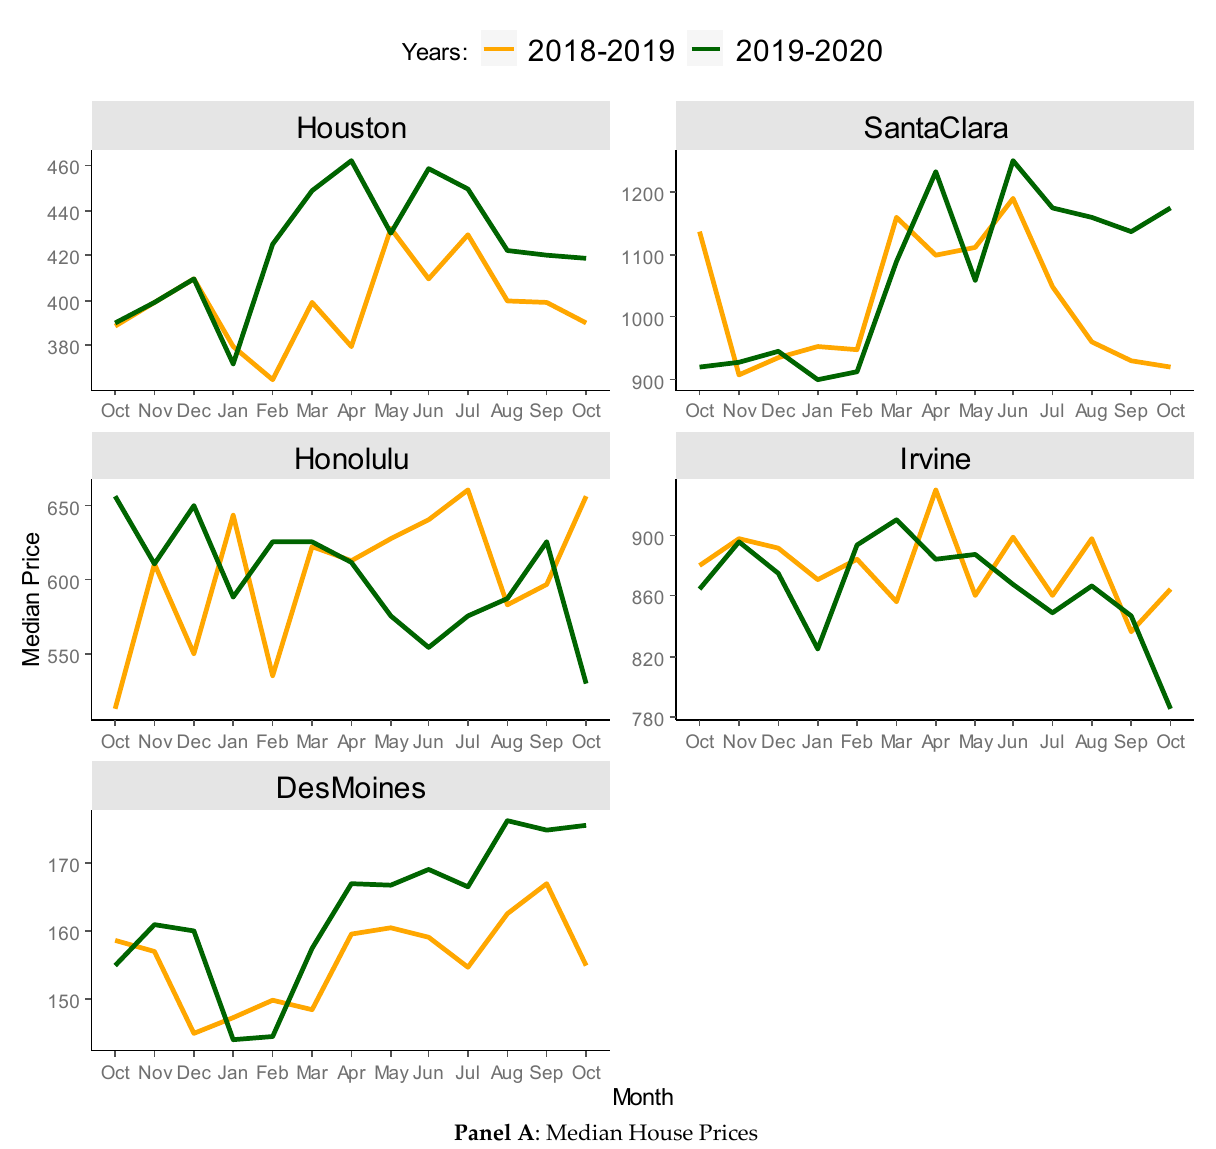
Panel A : Median House Prices